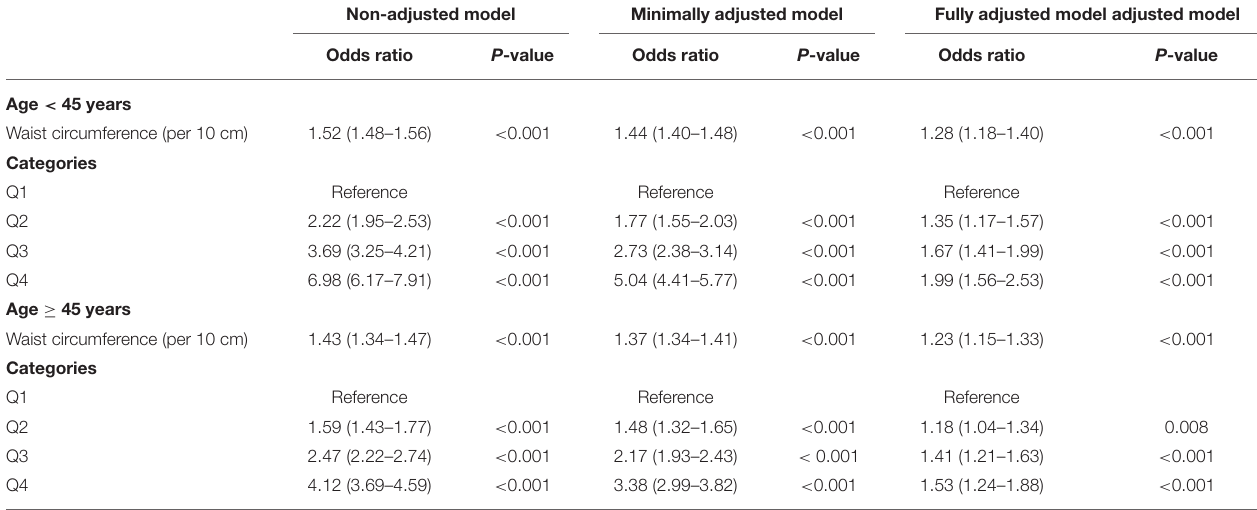
TABLE 3 | The association between waist circumference and (pre)